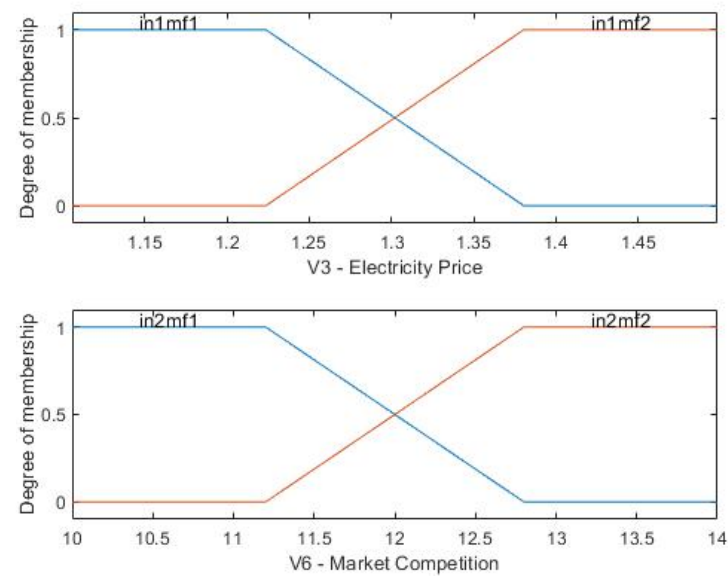
Figure 10. Optimal membership functions of the ANFIS for electricity consumption forecasting.